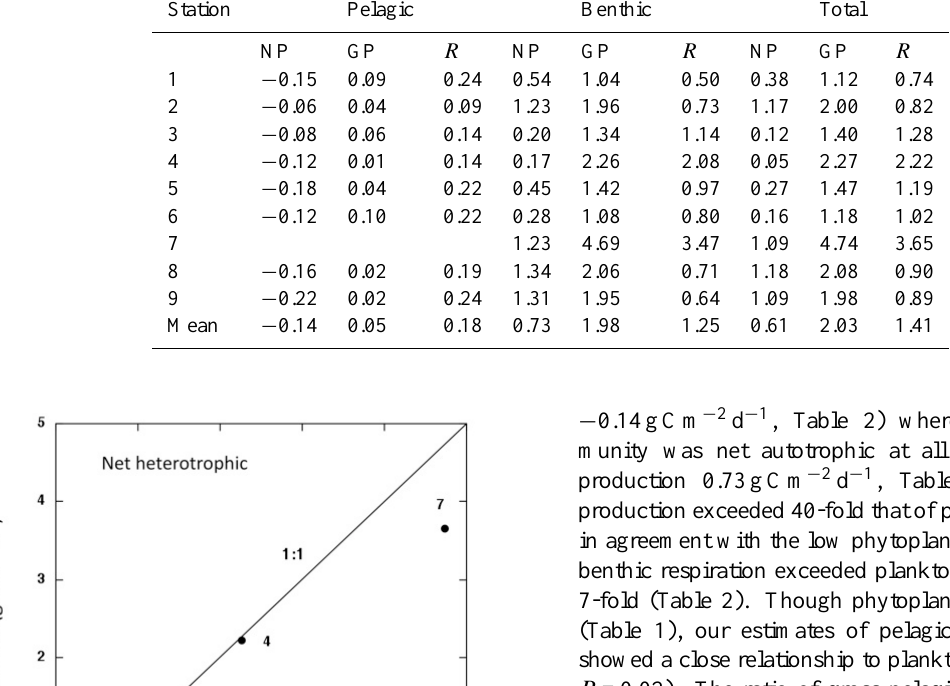
Table 2. Daily net community production (NCP), gross production (GP), and community respiration ( R ) of the pelagic, benthic and entire communities in nine shallow Do˜nana lagoos, based on 24h O 2 measurements. All rates in gCm − 2 d − 1 . Station